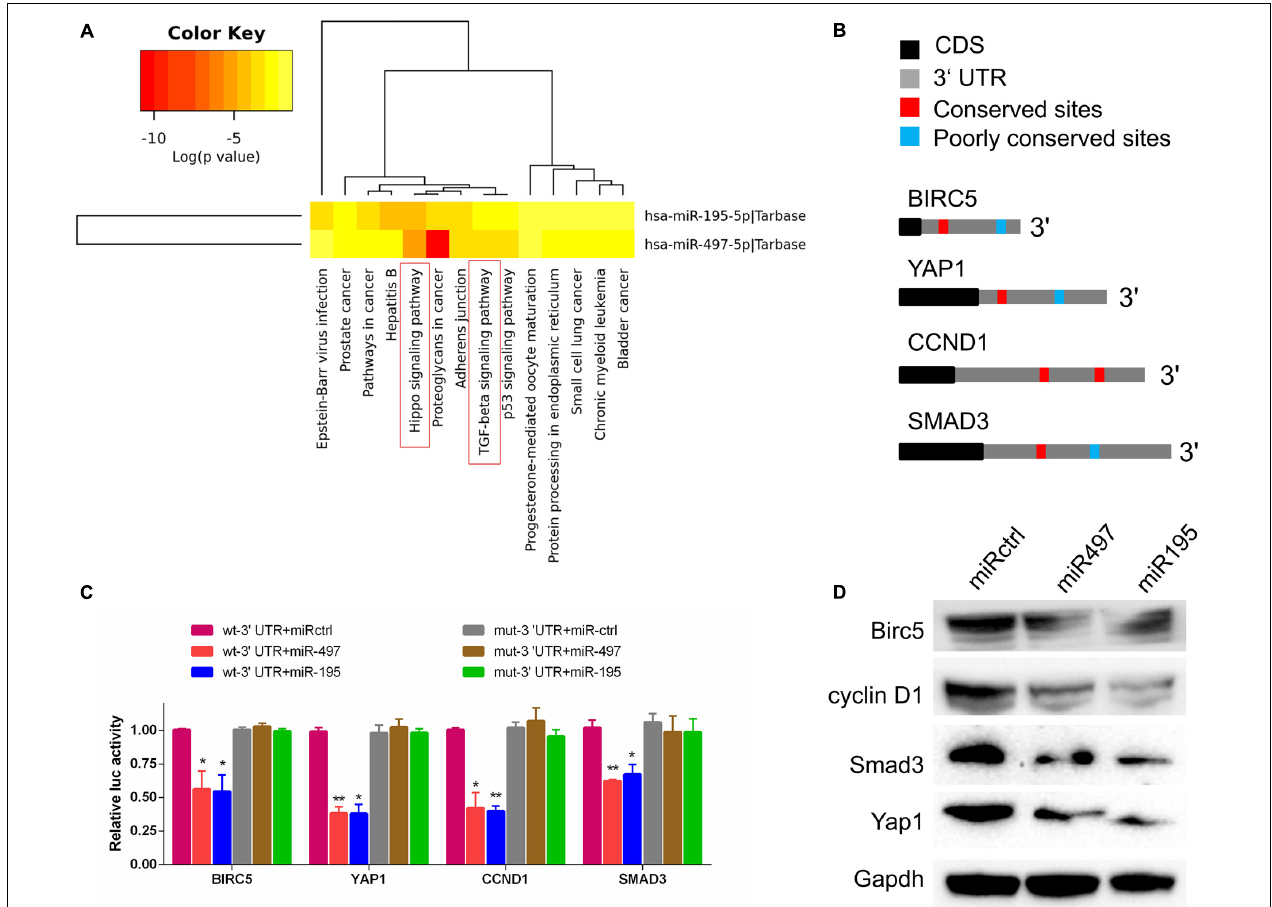
FIGURE 4 | MiR-497 and miR-195 directly suppressed multiple key components in Hippo/Yap and TGF- β signaling. (A) The Kyoto Encyclopedia of Genes and Genomes analysis of miR-497 and miR-195 target genes. (B) Predicted miR-497 and miR-195 binding conversed (red) and poorly conversed (blue) sites in 3 (cid:48) UTRs of Birc5, Yap1, CCND1, and Smad3. CDS, coding sequence. (C) Luciferase reporter assay of candidates predicted to be regulated by miR-497 or miR-195. Renilla luciferase activity was normalized to firefly activity. n = 3 independent experiments. * P < 0.01 and ** P < 0.01 by Student t test. (D) Western blot analysis of Birc5, cyclin D1, Smad3, and Yap1 in the indicated cells. Gapdh served as the loading control. Representative of three independent